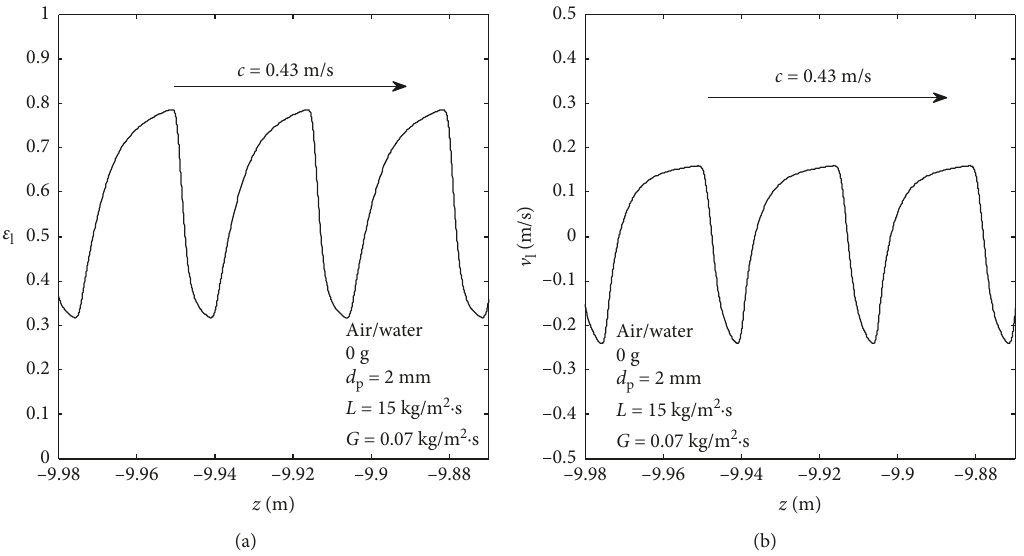
Figure 6: (a) Liquid saturation profile at c 0.43 m/s from traveling wave analysis (same system as in Figure 2(b)). (b) Liquid velocity profile (cid:31) at c 0.43m/s from traveling wave analysis (same system as in Figure 2(b)). (cid:31)